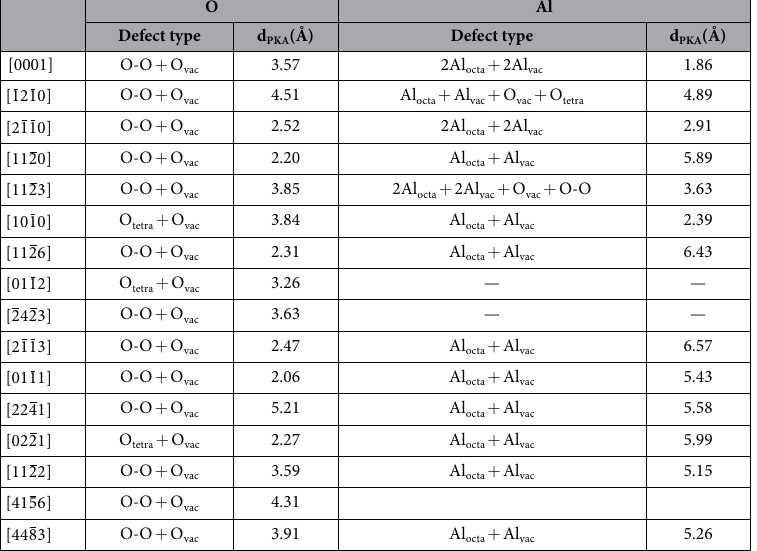
Table 3. The type of created defects and displacement (d PKA ) for O and Al recoils. O vac : oxygen vacancy; O tetra : oxygen interstitial occupying the tetrahedral site; O-O: oxygen-oxygen dumbbell pair; Al vac : aluminum vacancy; Al octa : aluminum interstitial occupying the octahedral